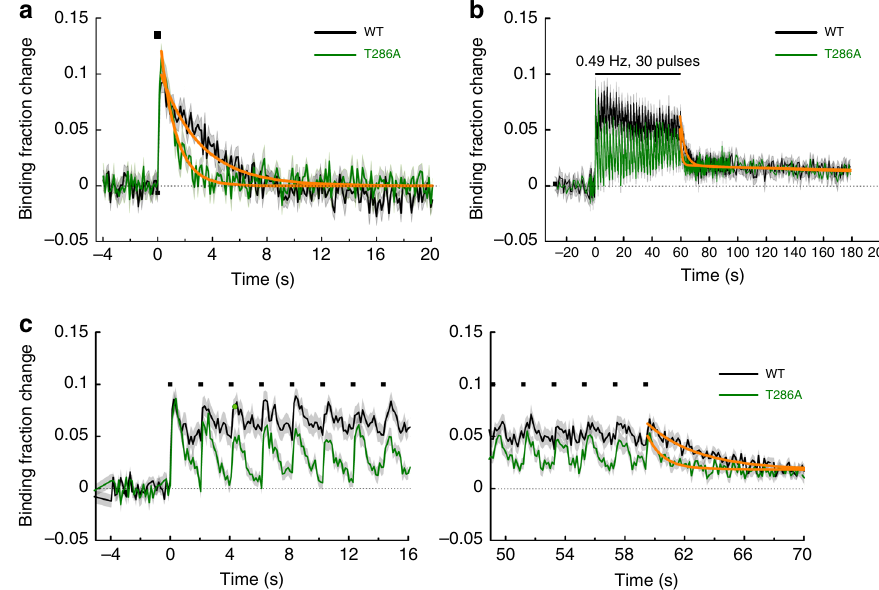
Fig. 4 CaMKII α T286A -CaM association during sLTP induction. a Averaged change in CaMKII α T286A -CaM association in a stimulated spine (green; n = 18 spines/4 neurons) in response to a single glutamate uncaging pulse (black square). The orange curve on CaMKII α T286A is obtained by curve fi tting of an exponential function: B ( t ) = B 0 ·e − t / τ . The dissociation time constant is obtained as τ = 1.2 ± 0.1 s. The data and fi tted curve for CaMKII α WT are from Fig. 3c for the comparison. b Averaged change in CaMKII α T286A -CaM association in stimulated spines (green; n = 24 spines/7 neurons) during glutamate uncaging at 0.49 Hz. The orange curve indicates the decay of binding fraction change obtained by curve fi tting of a double-exponential function: B ( t ) = B 0 [ P fast · exp( – t / τ fast ) + P slow · exp( – t / τ slow )]. The time constants for CaMKII α T286A are obtained as τ fast = 1.0 ± 0.2 s ( P fast = 63%) and τ slow = 356 ± 221 s ( P slow = 37%). The data and fi tted curve for CaMKII α WT (black) are from Fig. 2d for the comparison. c Expanded view of the initial phase (left) and the late (right) phase of plot in b . All data are shown in mean ± sem, and sem of time constants is obtained by bootstrapping